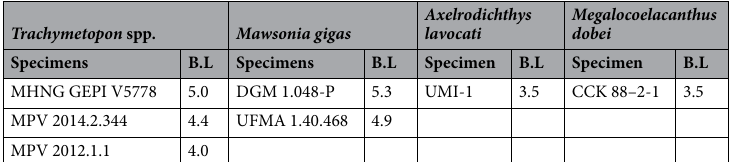
Trachymetopon spp.